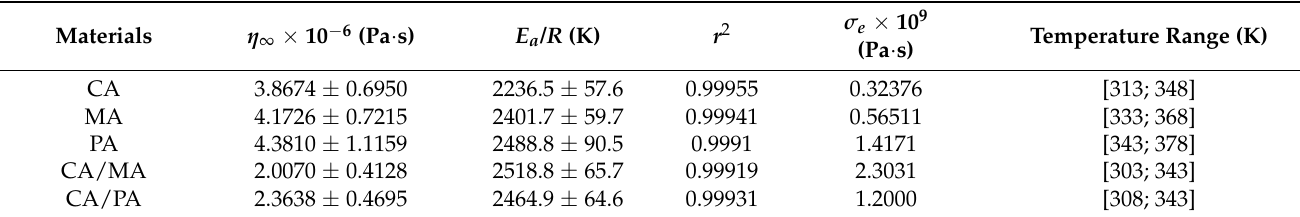
Table 11. Viscosity—Estimated values of the coefficients η ∞ and E a / R of the equation η ( T ) = η ∞ exp coefficient; σ e = standard deviation of the error) at pressure p = 0.1 MPa *.